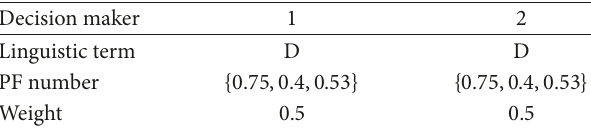
Table 8: Defuzzification of benefits 𝑁𝑥 𝑖 .